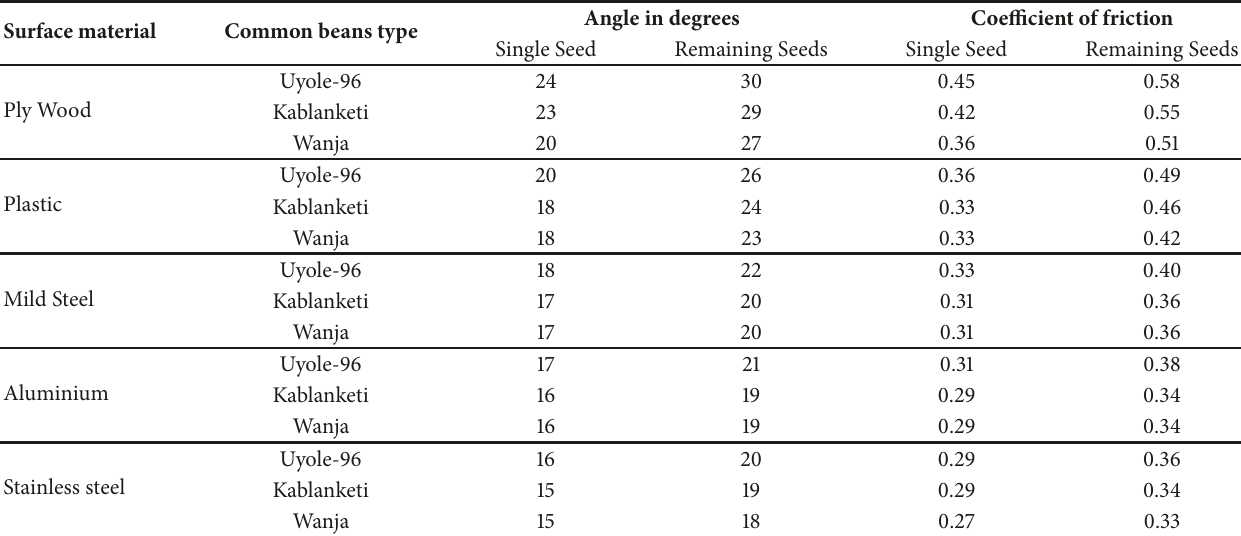
Table 4: Frictional properties for dissimilar sliding surface materials.